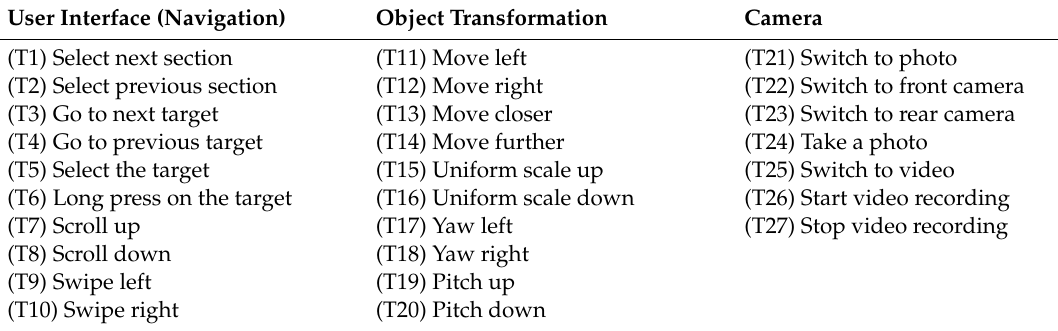
Table 1. The selected list of 27 HAR tasks used in our study. The tasks are classified into three di ff erent categories and presented via our HAR